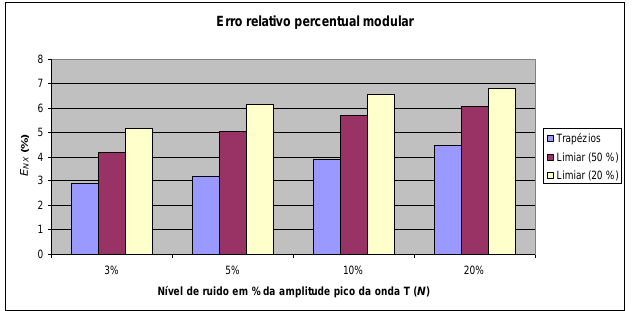
Figura 6. Erro relativo percentual modular versus nível de ruído para os algoritmos: TRA e THD. O valor dos diversos testes de hipótese (t- student) para cada algoritmo com respeito ao algoritmo dos trapézios está demarcado por uma probabilidade p ≤ 8,9